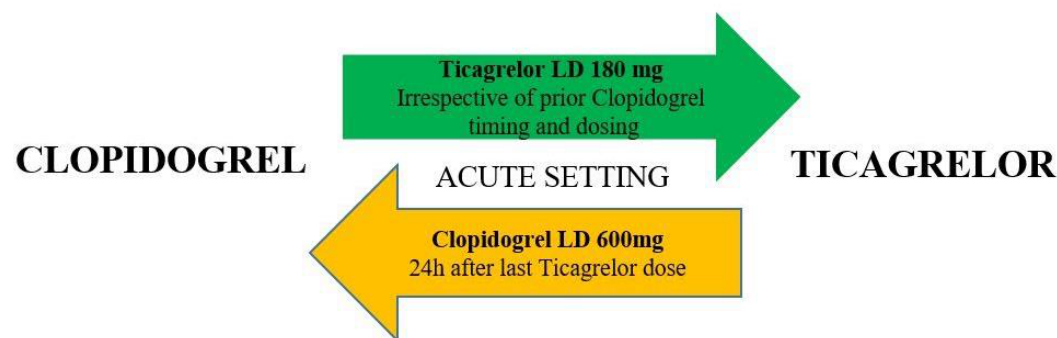
Figure 1. Algorithm for switching between oral P2Y12 inhibitors in the acute setting. LD = loading dose. Color-coding refers to the ESC Classes of Recommendations: green = Class I; orange = Class IIb (ESC Dual Antiplatelet Therapy Guidelines 2017).